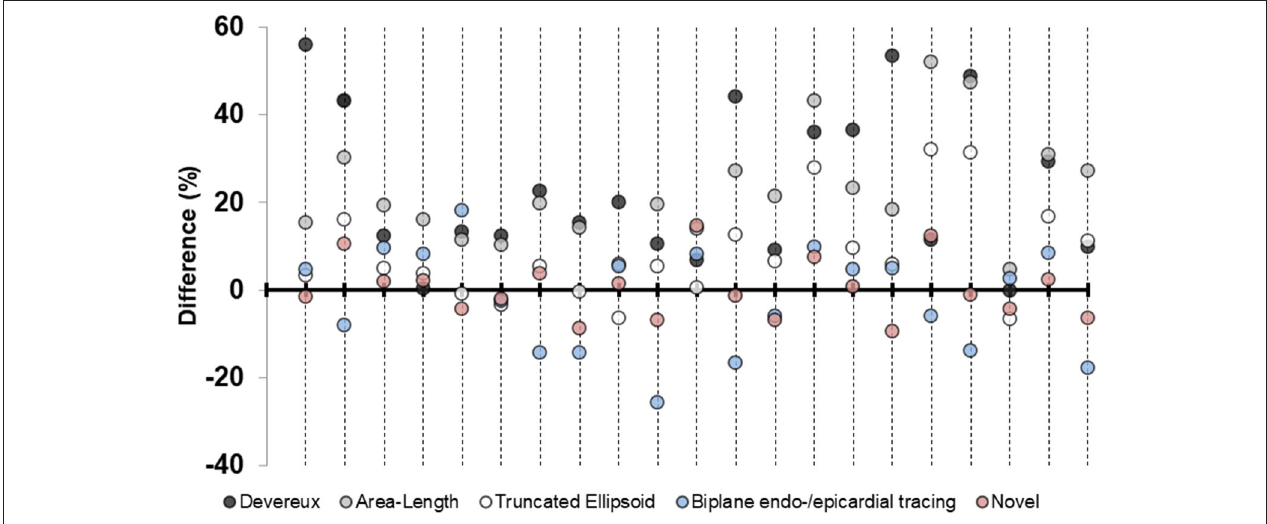
FIGURE 4 | Percentage differences in left ventricular mass plotted for each pig. Differences in percent for the five echocardiographic methods for left ventricular mass-quantification for the subgroup of pigs ( n = 21) where all measures were available. Positive value indicates overestimation by echocardiography compared to necropsy left ventricular mass. Each longitudinal line represents one pig.